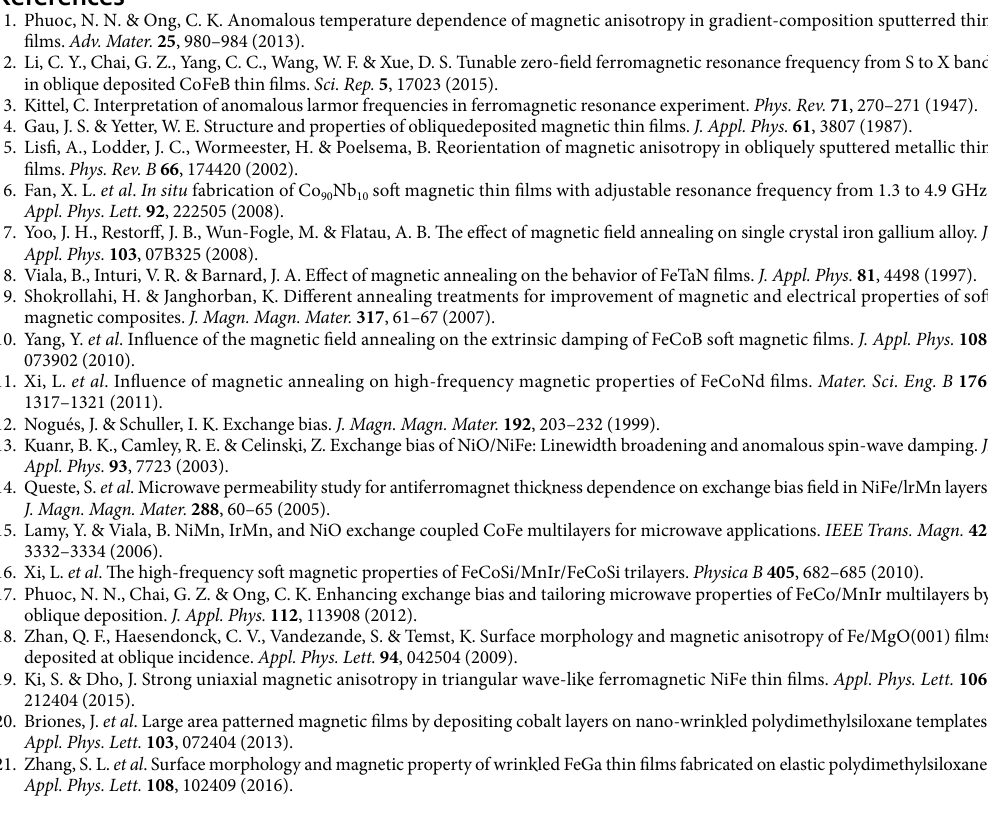
6 Scientific RepoRts | 7: 2837 | DOI:10.1038/s41598-017-03288-6